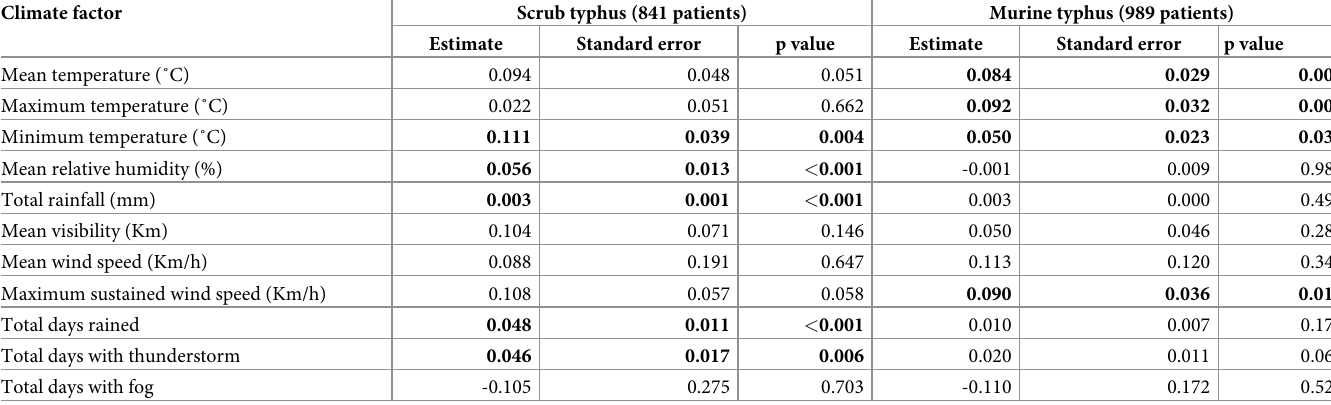
Table 3. Univariable regression analysis of climatic factors associated with scrub typhus and murine typhus from patients in Vientiane Capital, using climate data from Vientiane Capital. Climate factor Scrub typhus (841 patients) Murine typhus (989 patients)